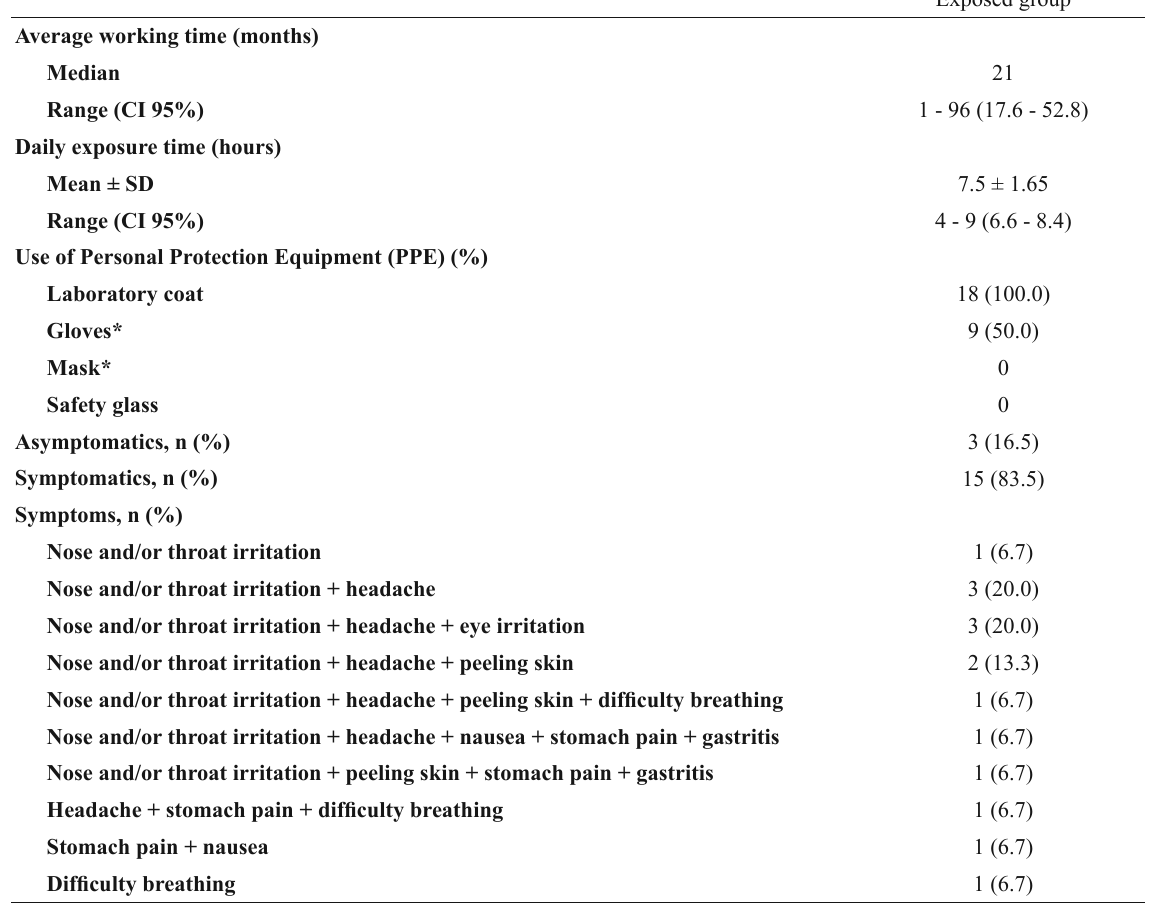
Characteristics and symptoms related to individuals’ occupational risk of the exposed